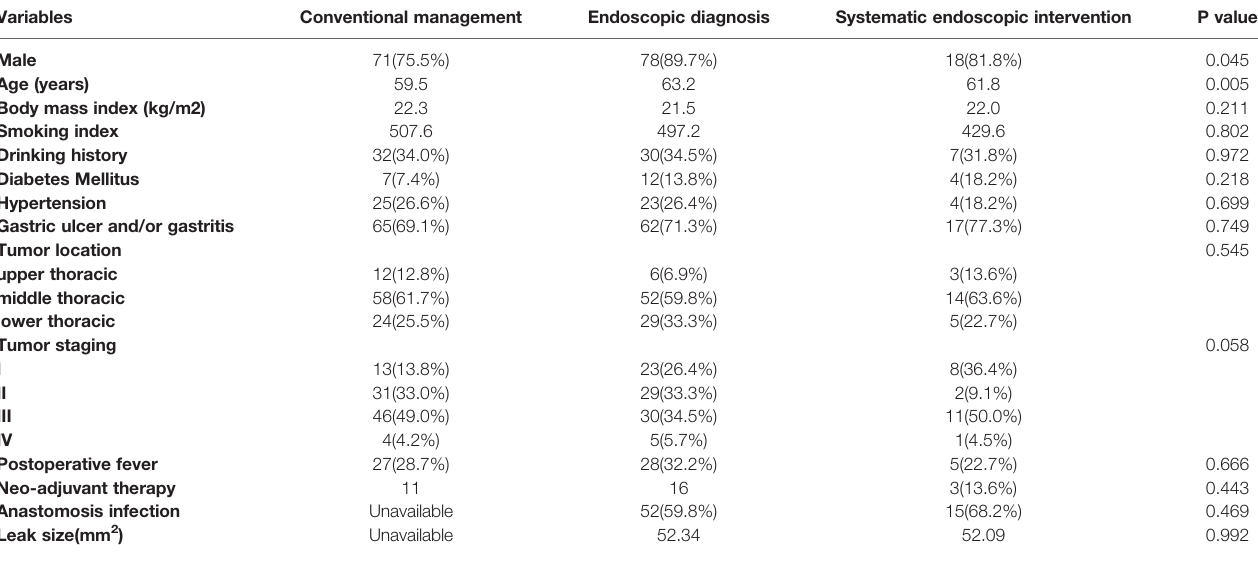
TABLE 2 | Comparison of clinical characteristics according to the diagnosis and treatment procedures.